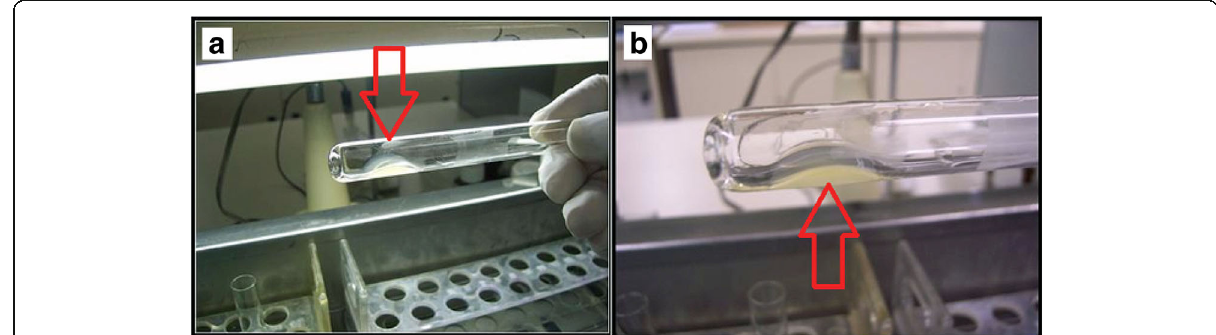
Fig. 8 Coagulant activity: a fibrin clot formed after incubation of human plasma with serine protease; b detail of fibrin network